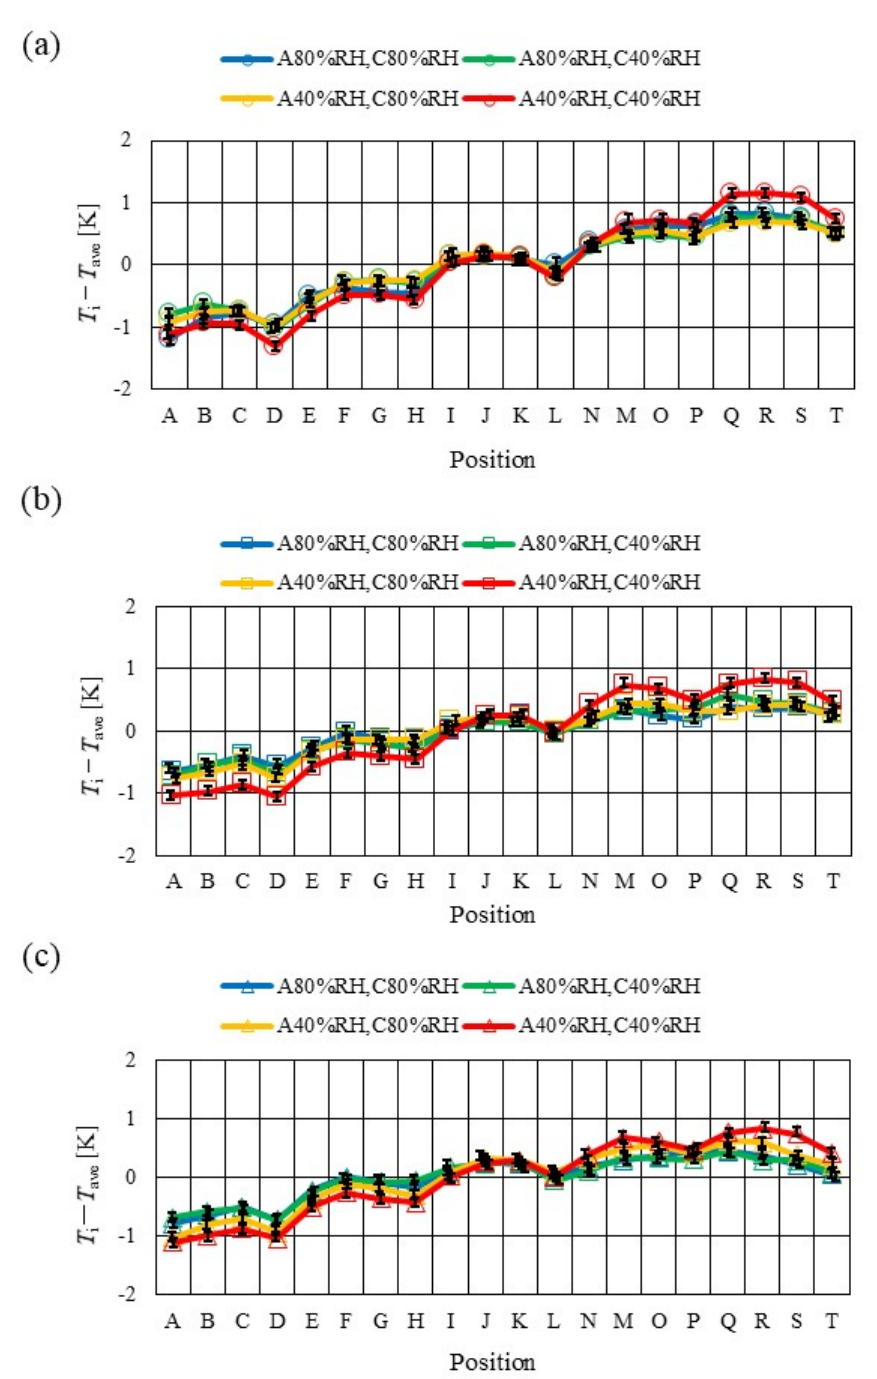
Figure 12. Comparison of the in-plane temperature distribution at the anode side among different RHs in the case of the separator thickness of 1.5 mm: ( a ) T init = 353 K; ( b ) T init = 363 K; ( c ) T init = 373 K.